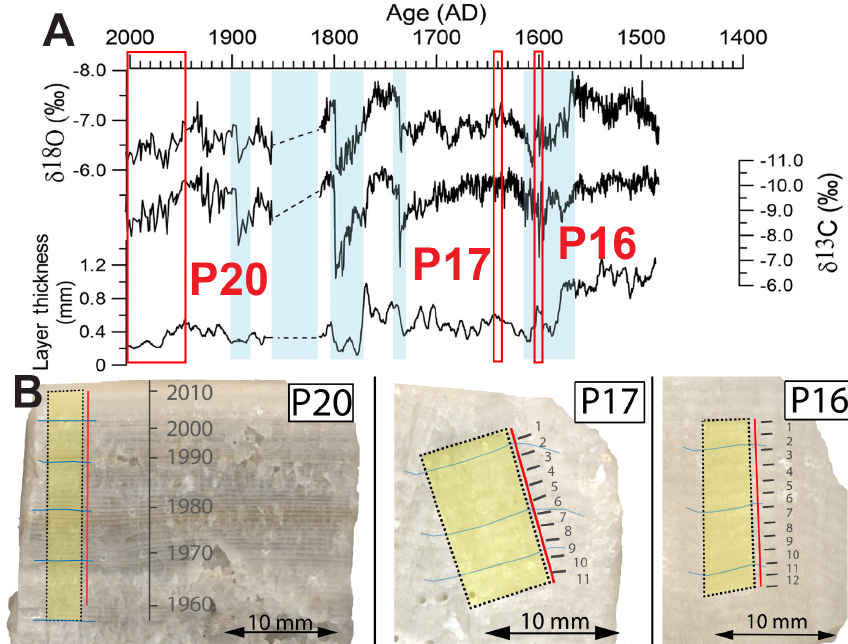
Figure 3. (a) Overview of a long ( ∼ 500yr) record of stable-isotope ratios and annual layer thickness through the Proserpine speleothem measured by Van Rampelbergh et al. (2015). Red boxes indicate the locations of high-resolution transects discussed in this study. (b) The three studied growth periods P20 (1960–2010CE), P17 (1633–1644 ± 30CE) and P16 (1593–1605 ± 30CE) are shown. The yellow rectangles mark the sections that were drilled and sampled for δ 13 C and δ 18 O analysis; the red lines represent the LA-ICP-MS transects. Numbers in grey indicate the observed layer couplets. Note that the images (b) of parts of the Proserpine speleothem that contain the three growth periods are oriented vertically (top of the picture upwards) but that the transects themselves are oriented parallel to the local growth direction (perpendicular to the growth laminae marked in blue). This results in transect P17’s orientation to be at a ∼ 25 ◦ angle with respect to the image (and the